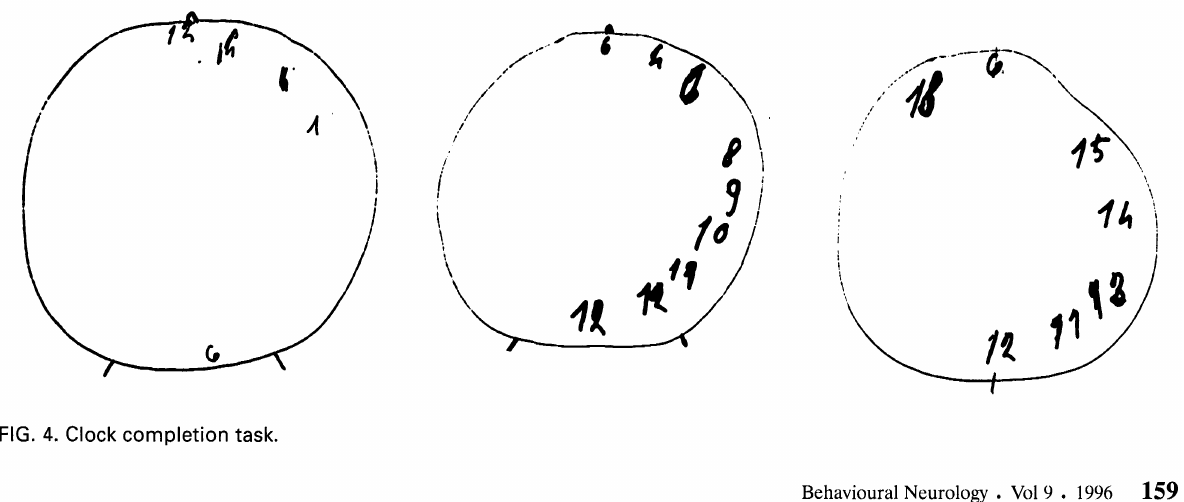
FIG. 4. Clock completion